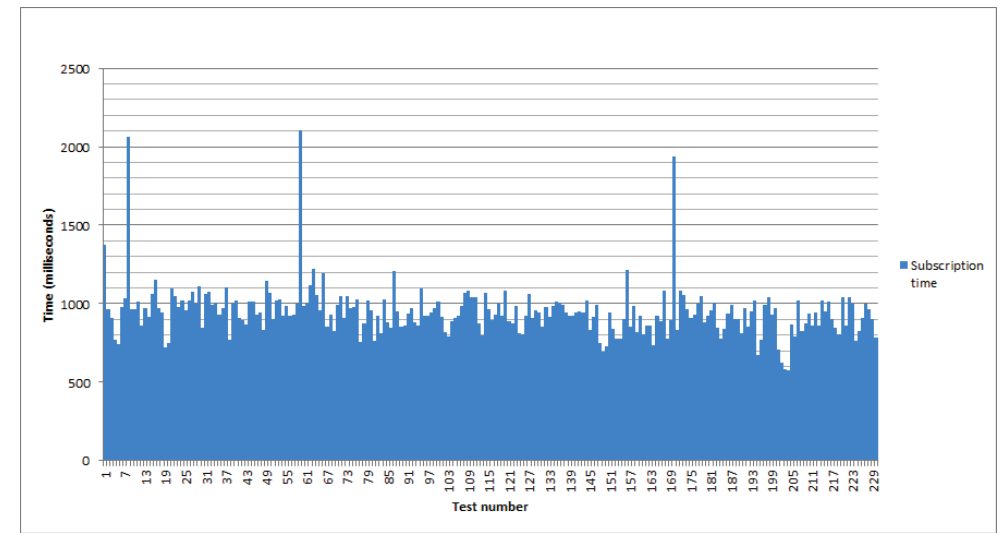
Figure 6. Time to subscribe the gateway to an event